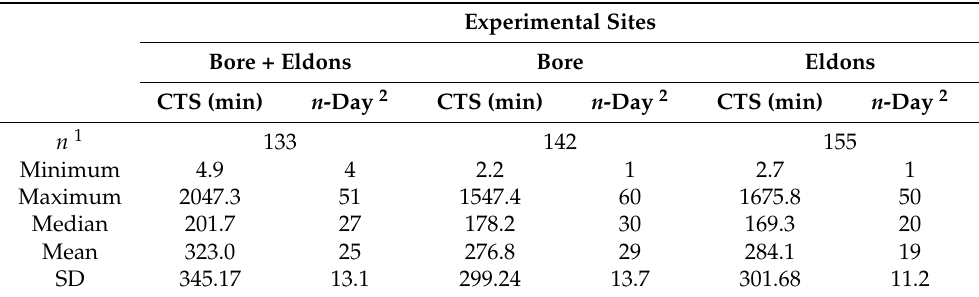
Table 1. Summary statistics of the total time spent at the automatic supplement weighing (ASW) units by individual cows over 62 days of data collection.